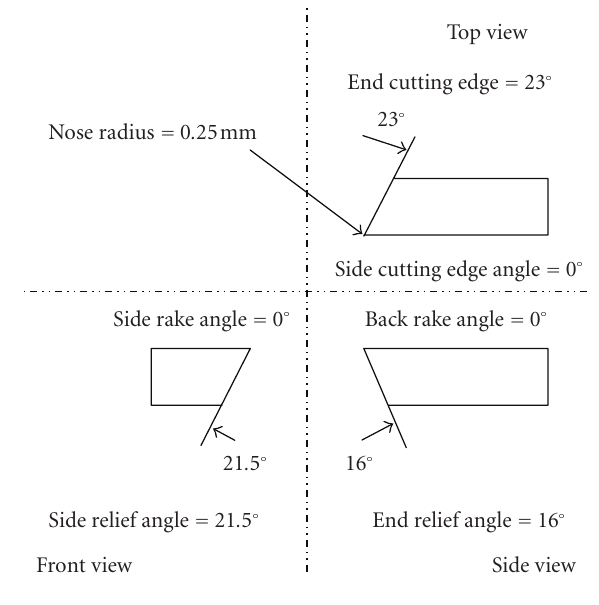
Figure 3.1 . Cutting tool